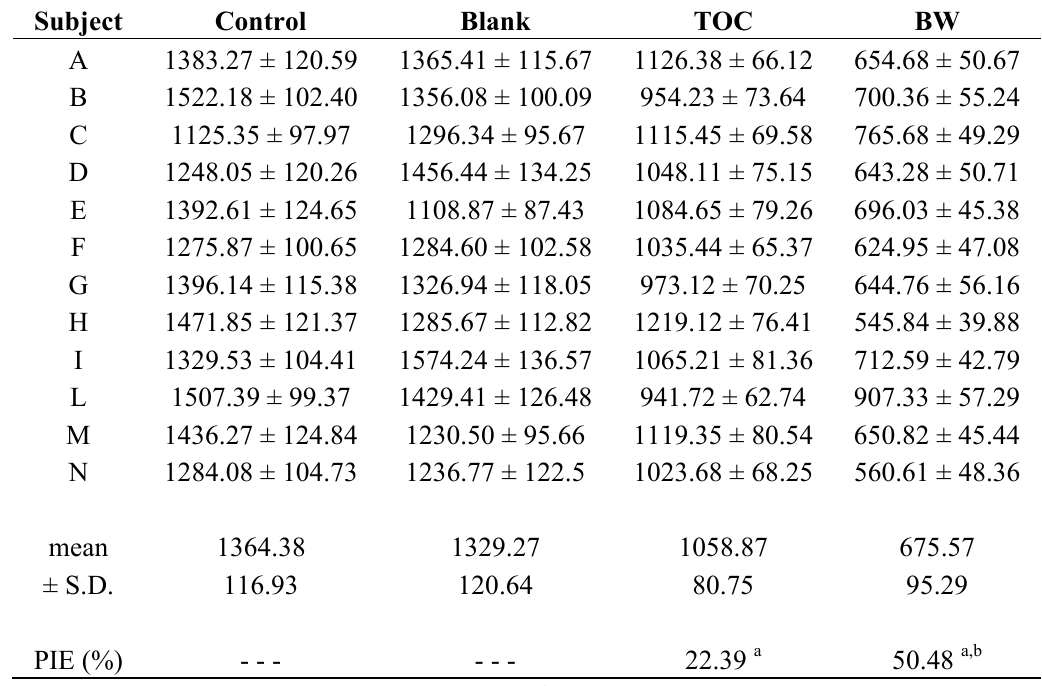
Table 4. AUC values obtained by applying either the blanch water extract (BW), 0–58 tocopheryl acetate (TOC) or blank formulations to UV-B-exposed skin sites. Data are expressed as mean ± SD and analyzed by Student’s t test for unpaired data.